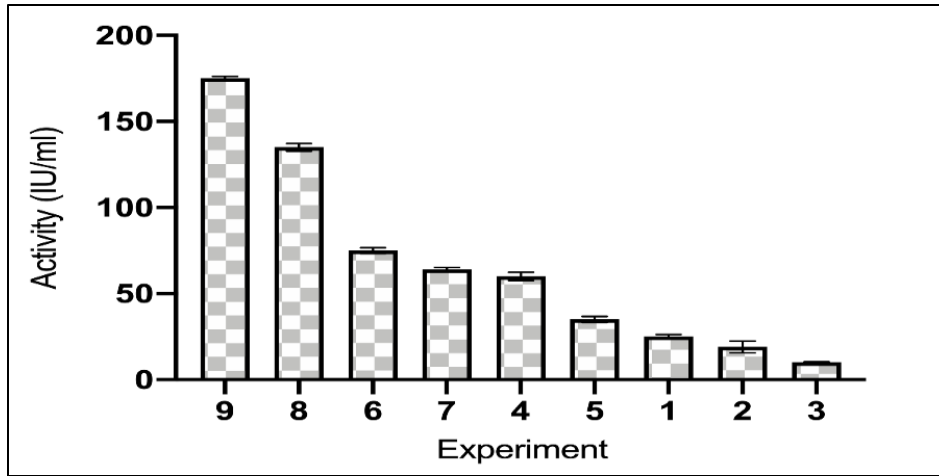
Figure 1. Asparaginase activities of Taguchi design experiments.